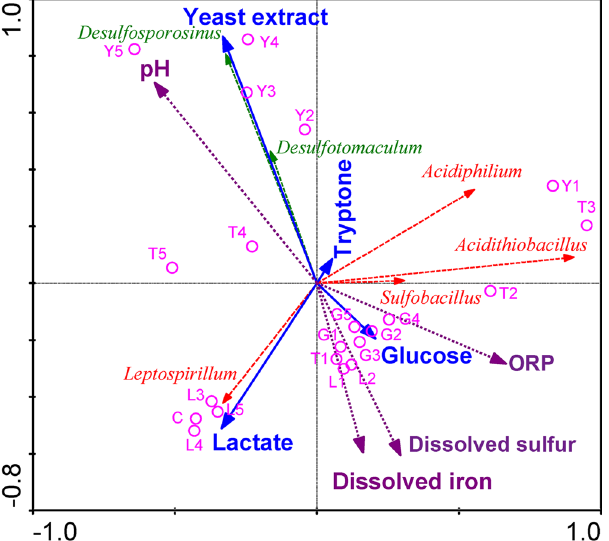
Figure 4. Redundancy analysis. Redundancy analysis triplots show the relationships between the different nutrients, the microbial community and the physiochemical properties. Nutrients are shown with solid lines and solid arrows; experiments with different nutrients and concentrations are shown with empty circles; microbes are shown with dashed lines; physiochemical properties are shown with dotted lines and solid